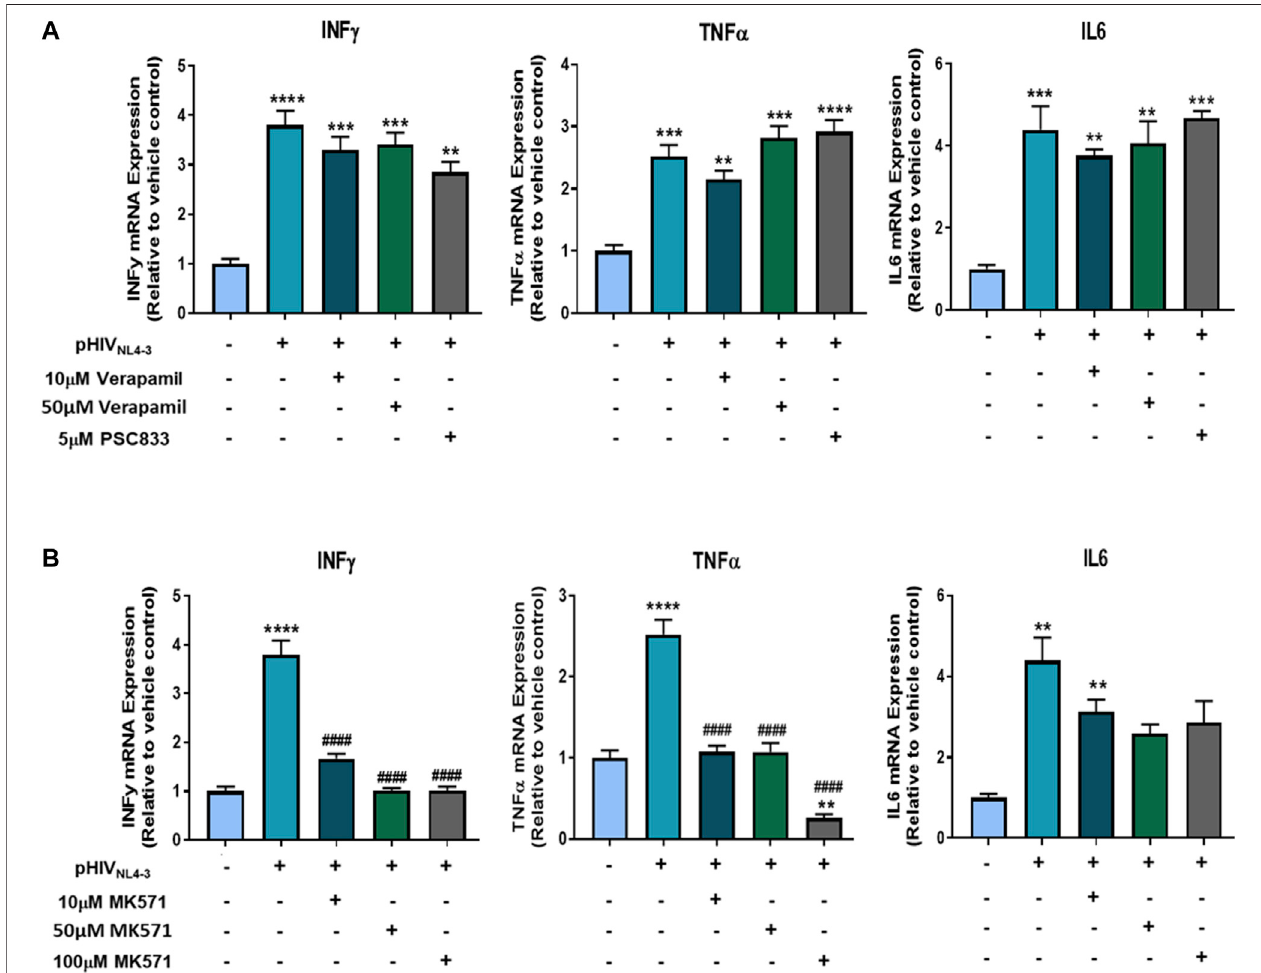
FIGURE 7 | Effects of P-gp and MRP1 inhibitors on proin fl ammatory cytokine mRNA expression following pHIV NL4-3 exposure. The effects of P-gp inhibitors verapamilandPSC833 (A) orMRP1inhibitorMK571 (B) onthemRNAexpressionofproin fl ammatorycytokinesfrompHIV NL4-3 exposedPBMCs.Cellswereexposedto vehicle, pHIV NL4-3 only, or pHIV NL4-3 in the presence of inhibitors for 48 h. mRNA levels were measured using qPCR. GAPDH was used as the housekeeping gene. Results are expressed as mean ± SD of experiments performed in cells obtained from three donors ( n (cid:2) 3 donors). Multiple comparisons were performed using one-wayANOVAandBonferroni ’ spost-hocanalysis; p < 0.05wasconsideredstatisticallysigni fi cant.*,statisticallysigni fi cantdifferencecomparedtountreatedcontrol; #, statistically signi fi cant difference compared to pHIV NL4-3 only. **, p < 0.01; ***, p < 0.001; ****, p < 0.0001; ####, p < 0.0001.